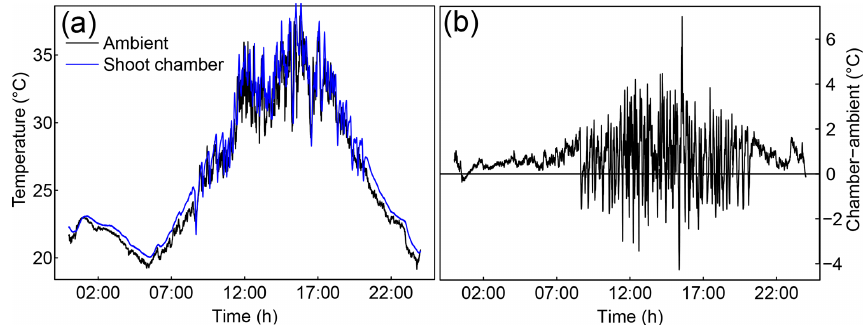
Figure 4. Example of the temperature control used with ShoTGa-gh7: ambient temperature and temperature in a shoot chamber in the greenhouse compartment (a) and the temperature difference between shoot chamber and ambient air (b) . Data were measured on 1 August 2019.